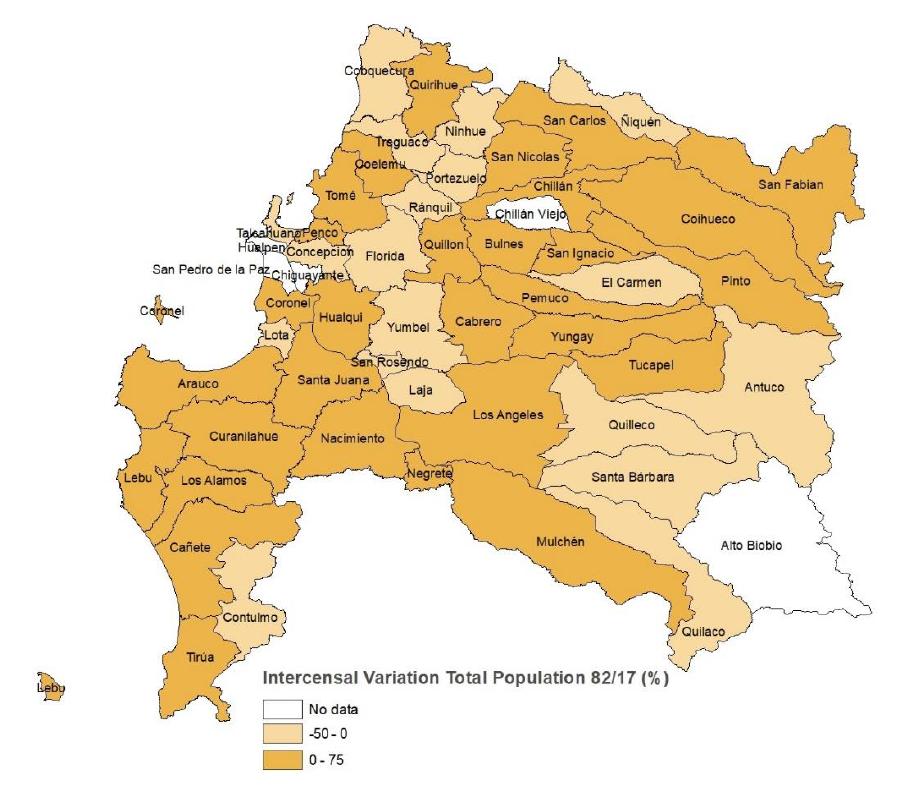
Figure 6. Variation (%) in total population between the Censuses of 1982 and 2017.